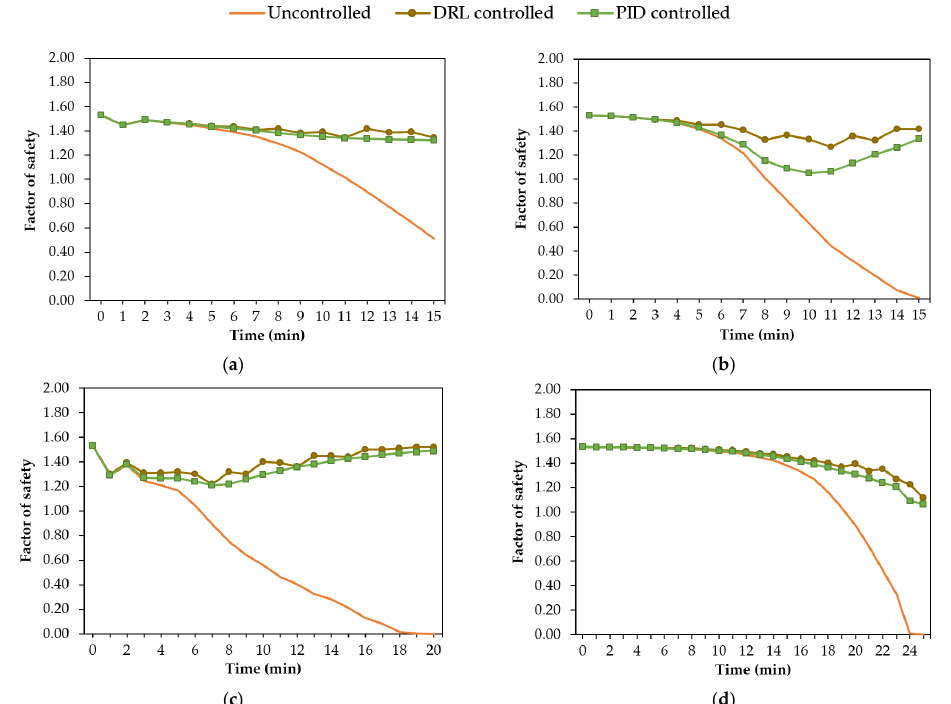
Figure 8. Variation in the slope’s factor of safety obtained for different control methods during rain- fall events: ( a ) 15-min-constant; ( b ) 15-min-normal; ( c ) 20-min-descending; ( d )